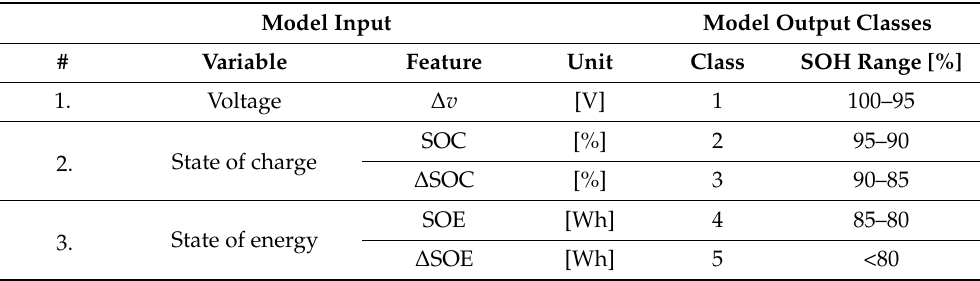
Table 2. Dataset characterization: the input and output of the ANN-based algorithm. The input features are computed on a buffer with a time length of 40